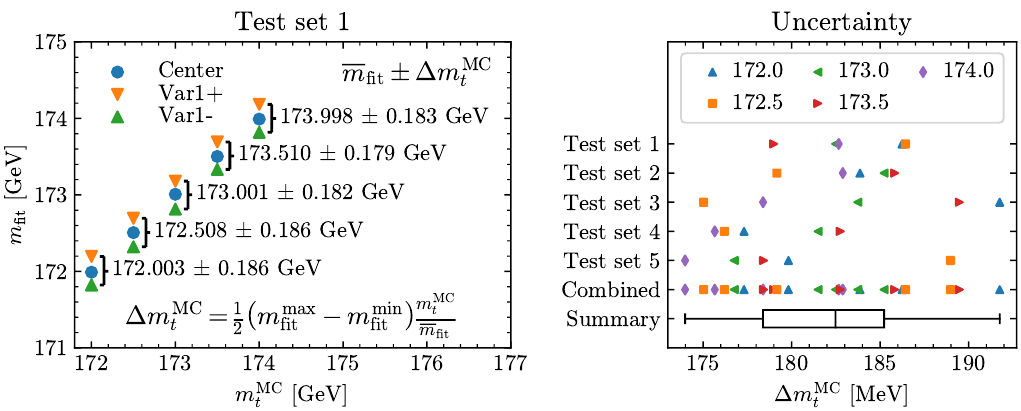
Figure 2. How uncertainties on m MC uncorrected histogram fitting method using the Var1 tune, but the same error estimation is used throughout. Left: we show the fitted mass for different truth m MC of the tune parameters. For each m MC We repeat the fits with 5 test sets. Right: the values of ∆ m MC shown. The markers correspond to specific m MC are shown in the box-and-whiskers plots (“summary” row of right